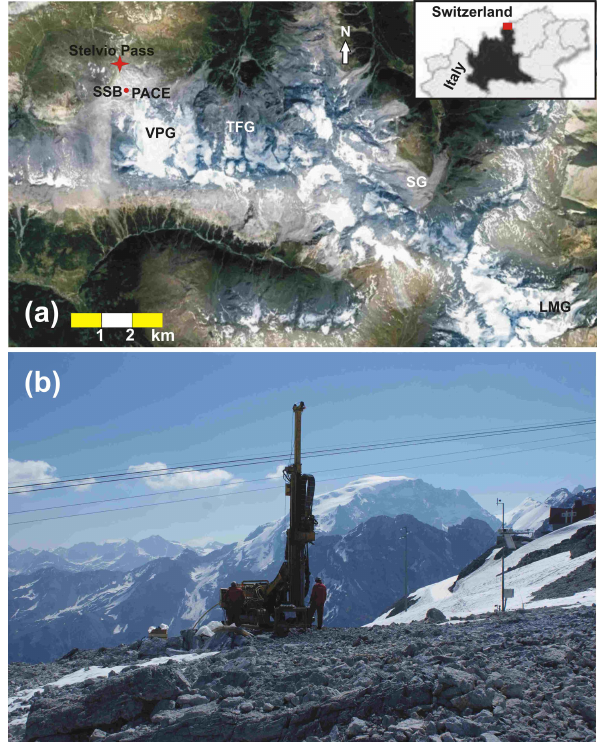
Figure 1. Study area: (a) location of the study area with the surrounding glaciers and the reconstructed glacier limits of the area (VPG: Vedretta Piana glacier; TFG: Trafoi glacier; SG: Solda glacier; LMG: La Mare glacier; PACE: PACE Borehole; SSB: Share Stelvio Borehole); (b) view of the drilling equipment during the re- alization of the SSB in summer